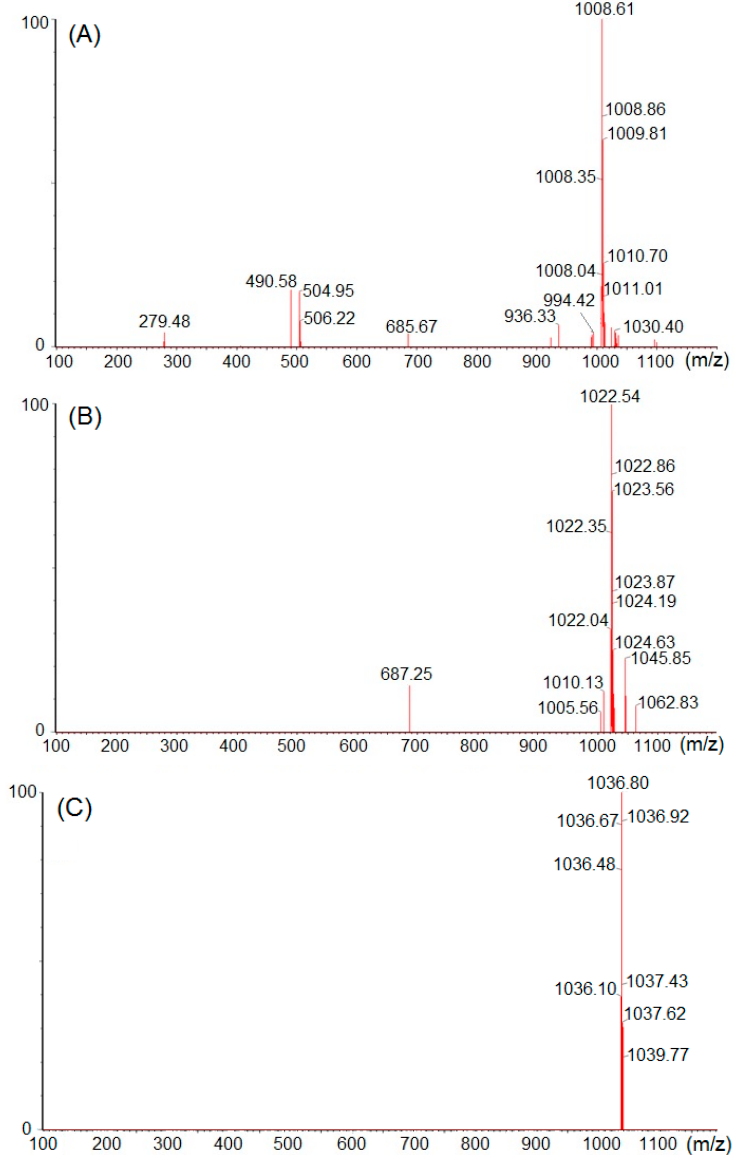
Figure 6. Mass spectral analyses ( A ) NT-5, ( B ) NT-6 and ( C ) NT-7.